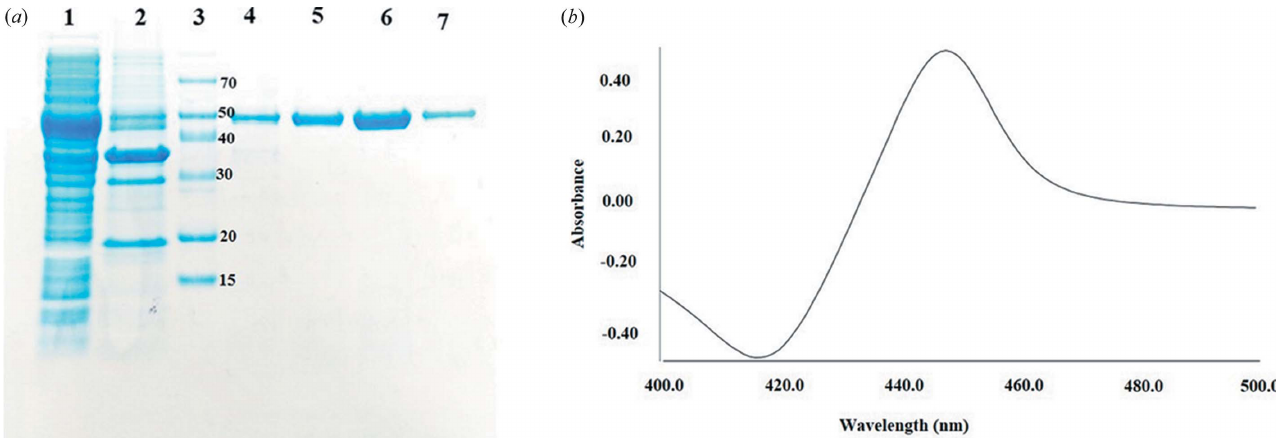
Figure 1 ( a ) Sodium dodecyl sulfate-polyacrylamide gel electrophoresis analysis of the purification of CYP105D18 [1, crude extract; 2, insoluble fraction; 3, marker (kDa); 4, 10 m M imidazole fraction; 5, 100 m M first fraction; 6, 100 m M second fraction and 7, 500 m M imidazole fraction]. The 100 m M imidazole second fraction (sample 6) was concentrated for in vitro reaction. The molecular weight of CYP105D18 is 44.3 kDa, and the protein was overexpressed using the pET28 vector in the C41 host. ( b ) Dithionite reduced the CO-bound form of